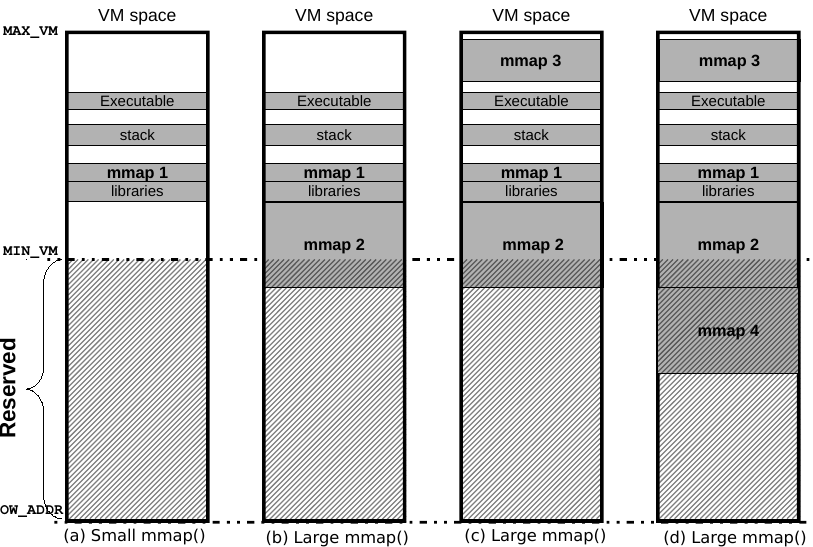
Figure 15. ASLR-NG: A 50% example of a reserved